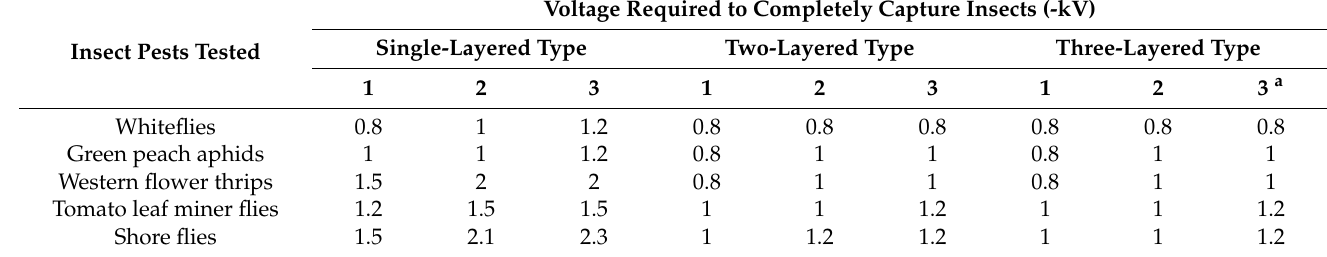
Table 2. Capture of insect pests blown toward the insulated conductor wires by different types of double-charged dipolar electric field screens (DD-screens) [8,41,42].